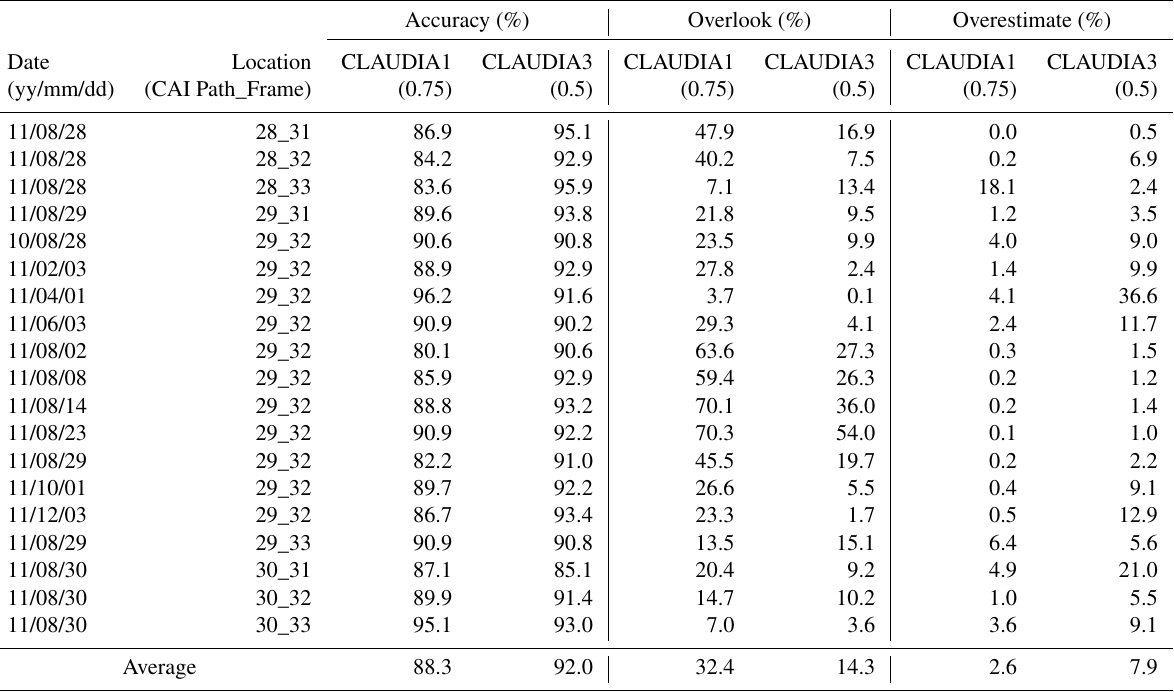
Table 6. Results for integrated-CCL thresholds of the maximum accuracy values in Fig. 11 (CLAUDIA1–CAI: 0.75, CLAUDIA3–CAI: 0.5) in the Amazon. Accuracy (%) Overlook